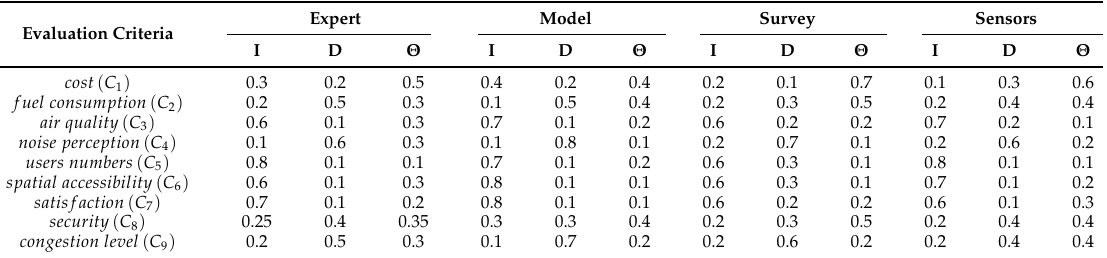
Table 5. Data collection of BPAs at the post-test stage